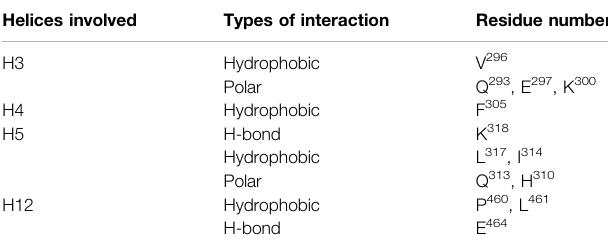
TABLE 3 | Interaction analysis of FXR with peptide within 4.5